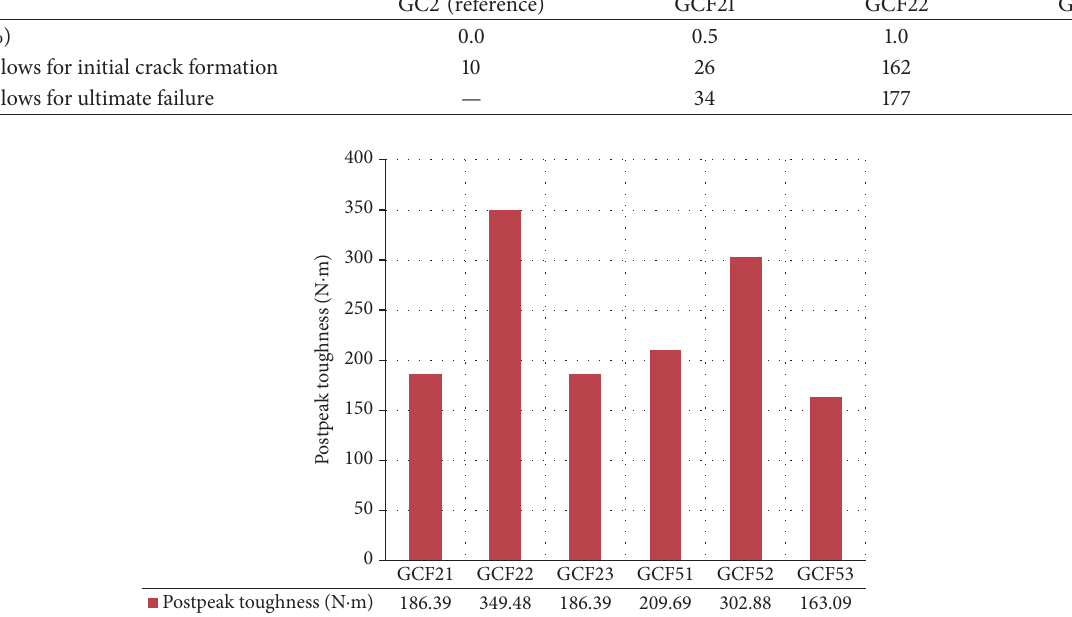
Figure 12: Postpeak toughness of each percentage of fibre reinforced geopolymer concrete (GCF21, GCF22, and GCF23).